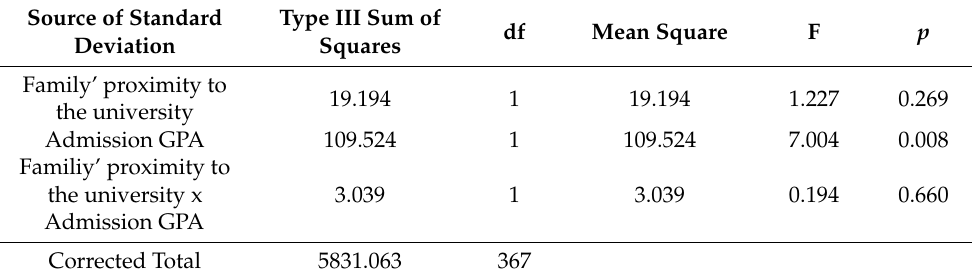
Table 6. ANOVA bifactorial for the dependent variable dropout intention